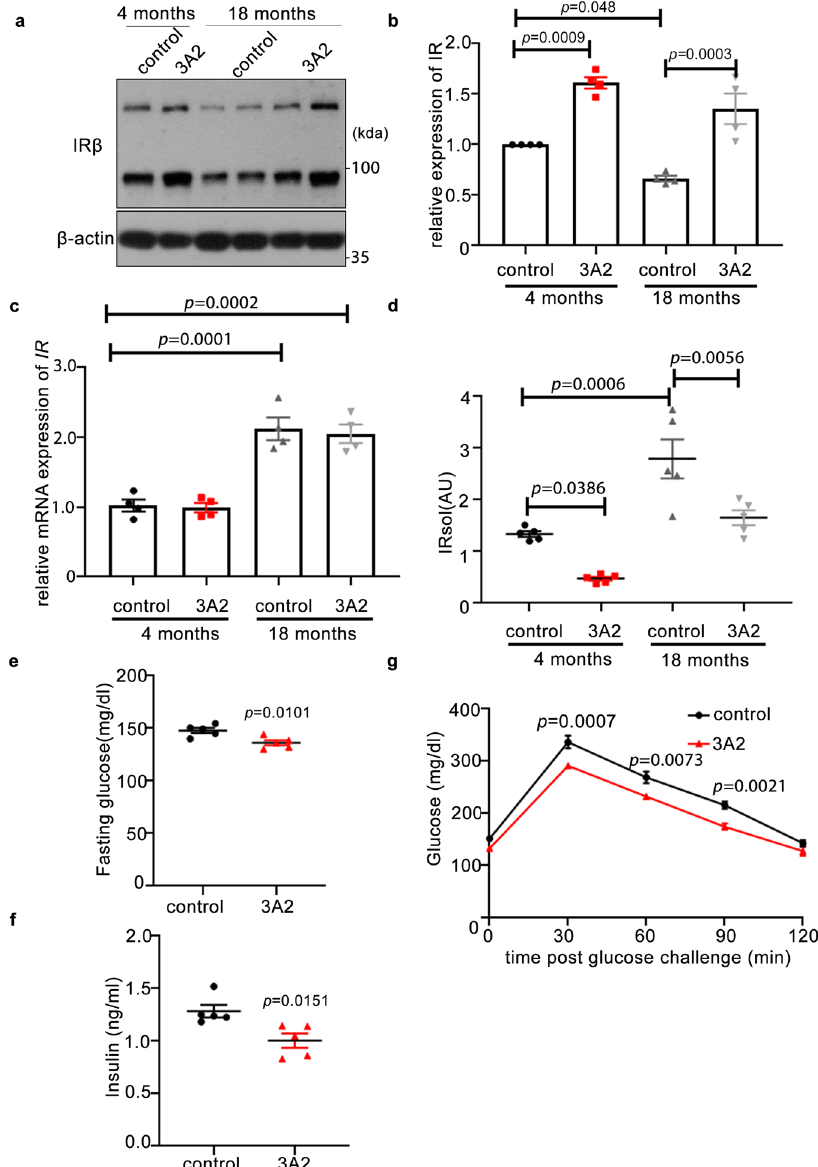
Fig. 5 Pharmacological inhibition of MT1-MMP improves insulin sensitivity in aged mice. Male mice at 4- and 18 months old on chow diet received treatment (twice a week) with either 3A2 antibody or control IgG for 4 weeks. a , b Western blotting ( a ) and qPCR analyses ( c ) on the expression of IR in the livers. The relative expression of IR protein level in relative to β -actin levels was quanti fi ed in ( b ) ( n = 4). d The level of sIR was measured in the plasma ( n = 5). e – g Fasting plasma glucose ( n = 5). e Fasting plasma insulin ( n = 5). f Glucose-tolerance test ( n = 5) ( g ) in mice. Data are reported as average ± s.e.m.; two-sided unpaired t test ( e – f ) or one-way ANOVA ( b – d , g ). Source data are provided as a Source Data fi